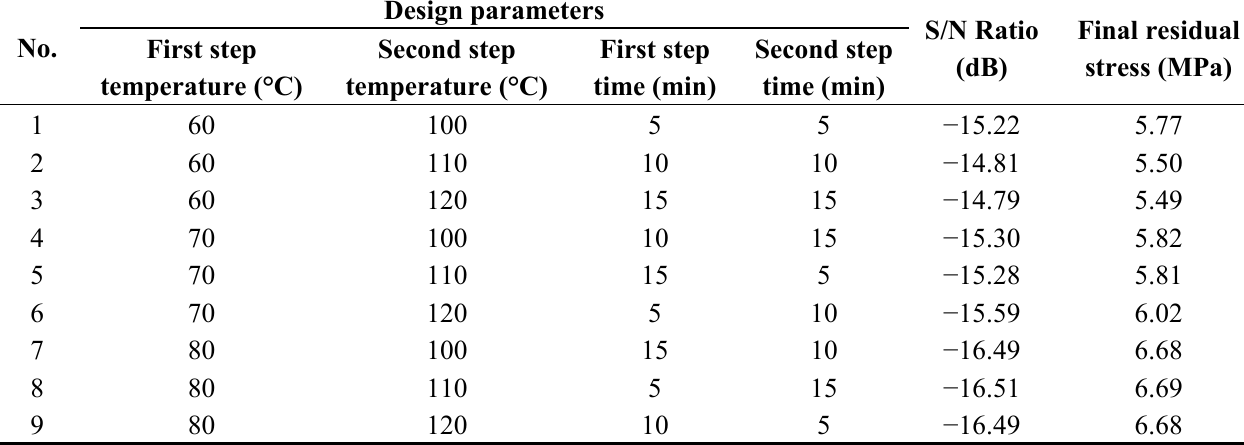
) of the DOE of the three-step cure 9